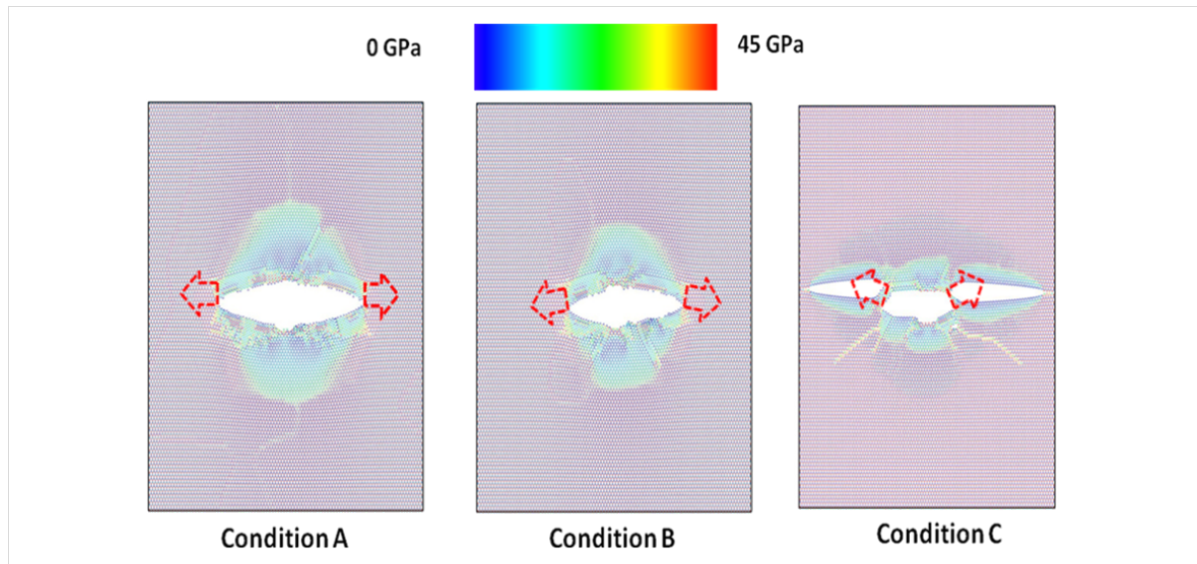
Figure 7: The von Mises stress distribution after crack extension for three crack tip types.